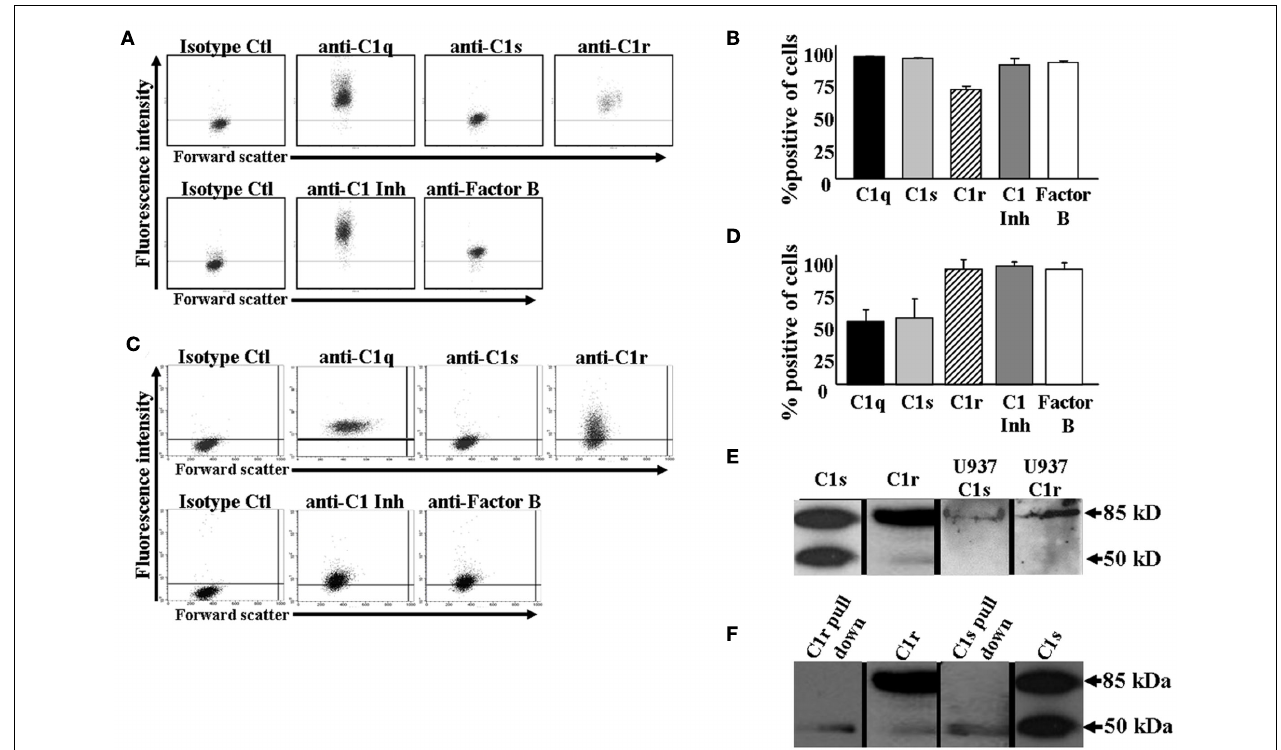
(D) . (E) C1s and C1r are produced by U937 cells. U937 whole cell lysates were subjected to SDS-PAGE and subsequently visualized byWestern blotting using GaH C1s and RaH C1r, followed by HRP-conjugated secondary Abs. Purified C1s and C1r were run as positive controls ( n = 3). (F) C1 complex is formed on U937 cells. Anti-C1q conjugated agarose beads were incubated with U937 whole cell lysates.The bound proteins were subjected to SDS-PAGE followed byWestern blotting using anti-C1s and anti-C1r and HRP-conjugated secondary Abs. Purified C1s and C1r were run as positive controls ( n =